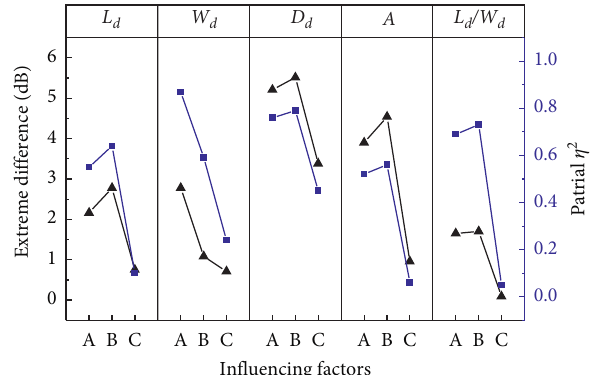
Figure 5: Statistical results using Taguchi method and multivariate analysis of